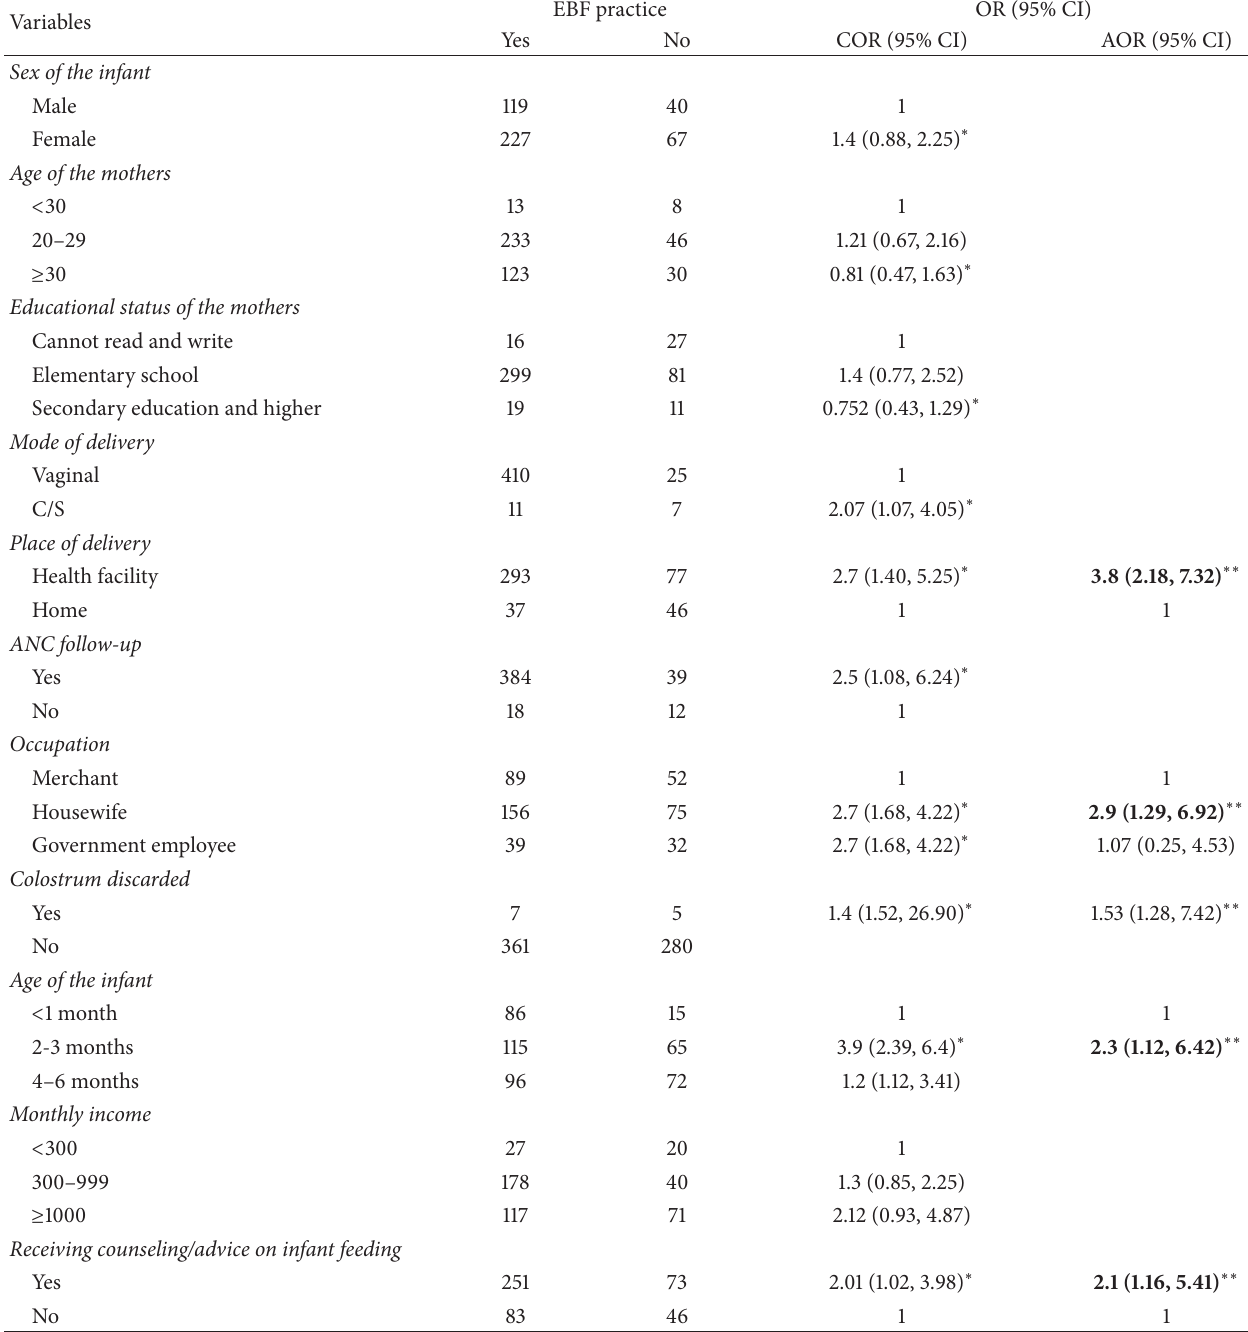
Table 4: Bivariate and multivariate analysis of factors associated with exclusive breastfeeding practices among mothers who gave birth in the last 6 months ( 𝑛 = 453 ) in Debre Tabor town, 2014. ∗ 𝑃 > 0.05 ; ∗∗ 𝑃 ≥ 0.05